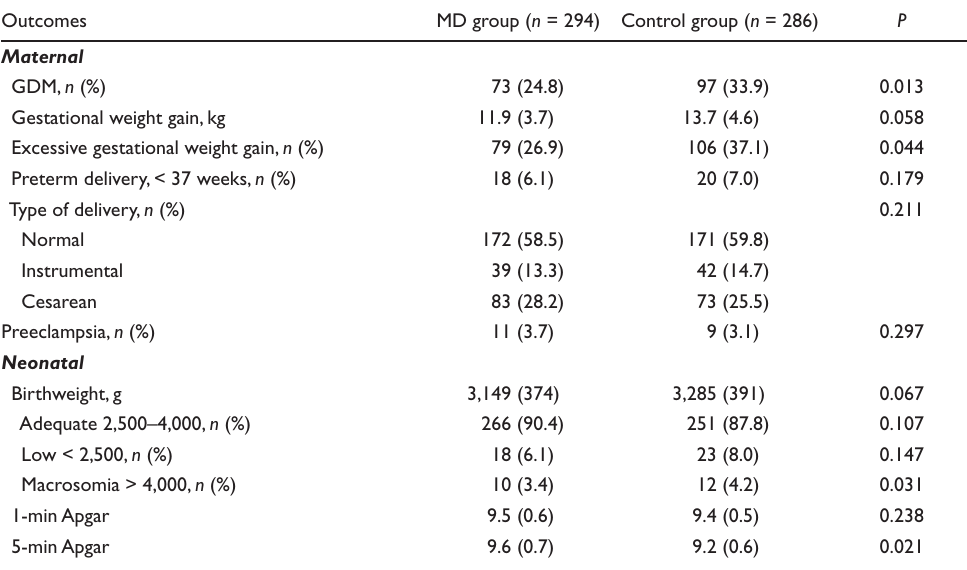
Table 4. Maternal and neonatal outcomes of the study Outcomes